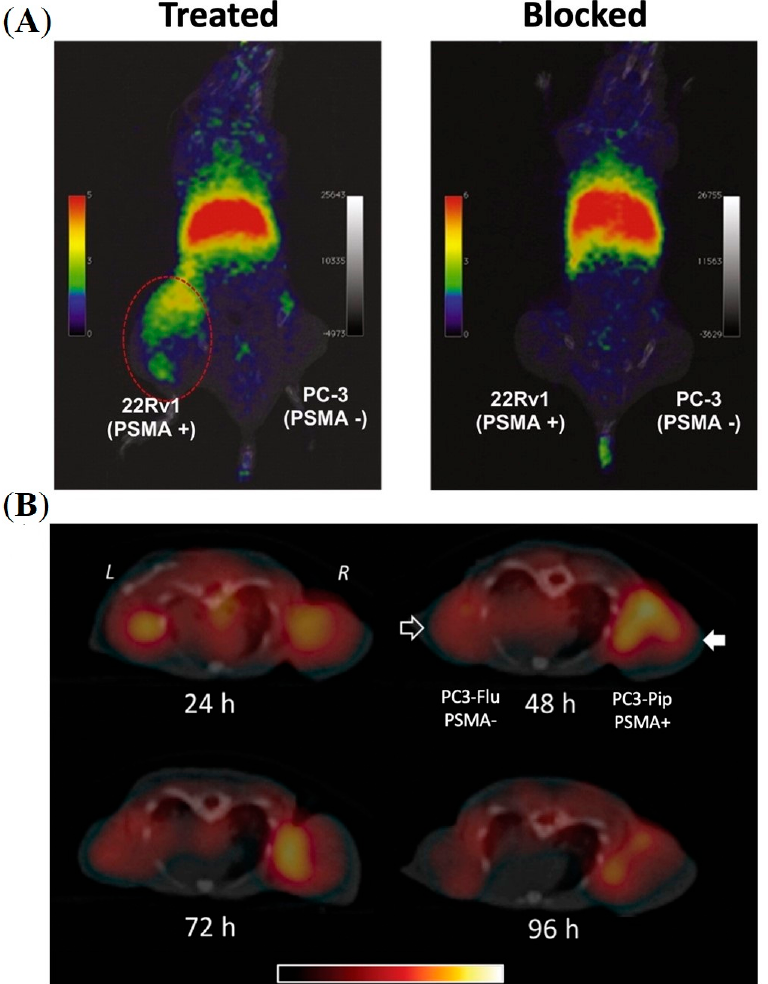
Figure 4. Imaging of PSMA-labelled iron oxide nanoparticles in prostate cancer murine models. ( A ) In vivo PET imaging of a mouse model bearing PSMA+ 22rv1 and PSMA—PC3 tumors at 1 h post-injection of PSMA-targeted iron oxide NPs encapsulated with DOTA- and ACUPA-conjugated PEGs. Reprinted with permission from Ref [40]. Copyright 2016, Elsevier. ( B ) In vivo SPECT-CT imaging of PSMA-targeted iron oxide NPs in mouse model bearing PSMA+ PC3-Pip and PSMA- PC3-Flu tumors over 4 days. Reprinted with permission from Ref [42]. Copyright 2015, Royal Society of Chemistry.